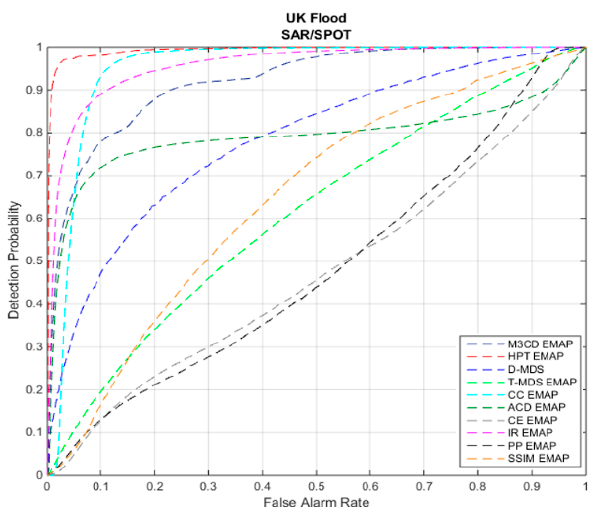
Figure 3. ROC curves for Image Pair-1 (SAR/SPOT) without EMAP. ROC: Receiver operating characteristics; EMAP: Extended Multi-Attribute Profiles.